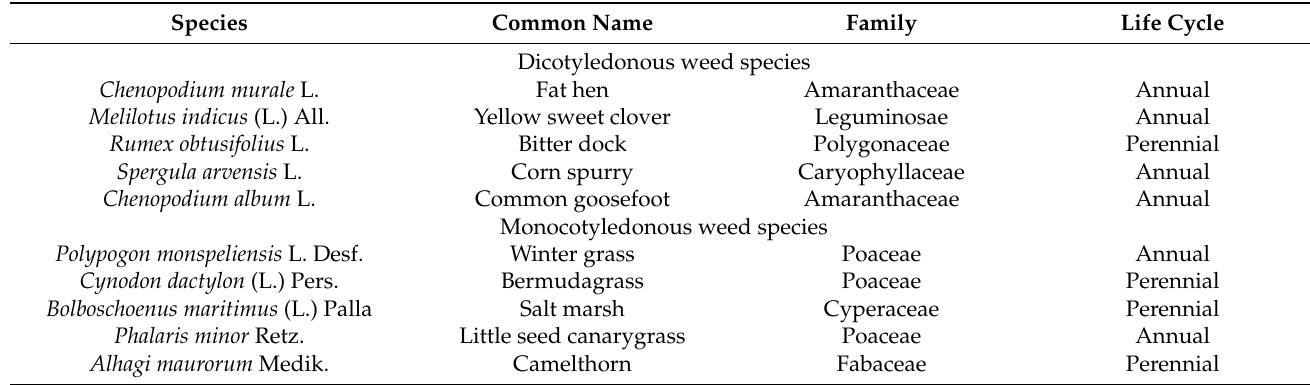
Table 4. Common and Latin names, family and life cycle of different weed species recorded in wheat crop during both years of the study.